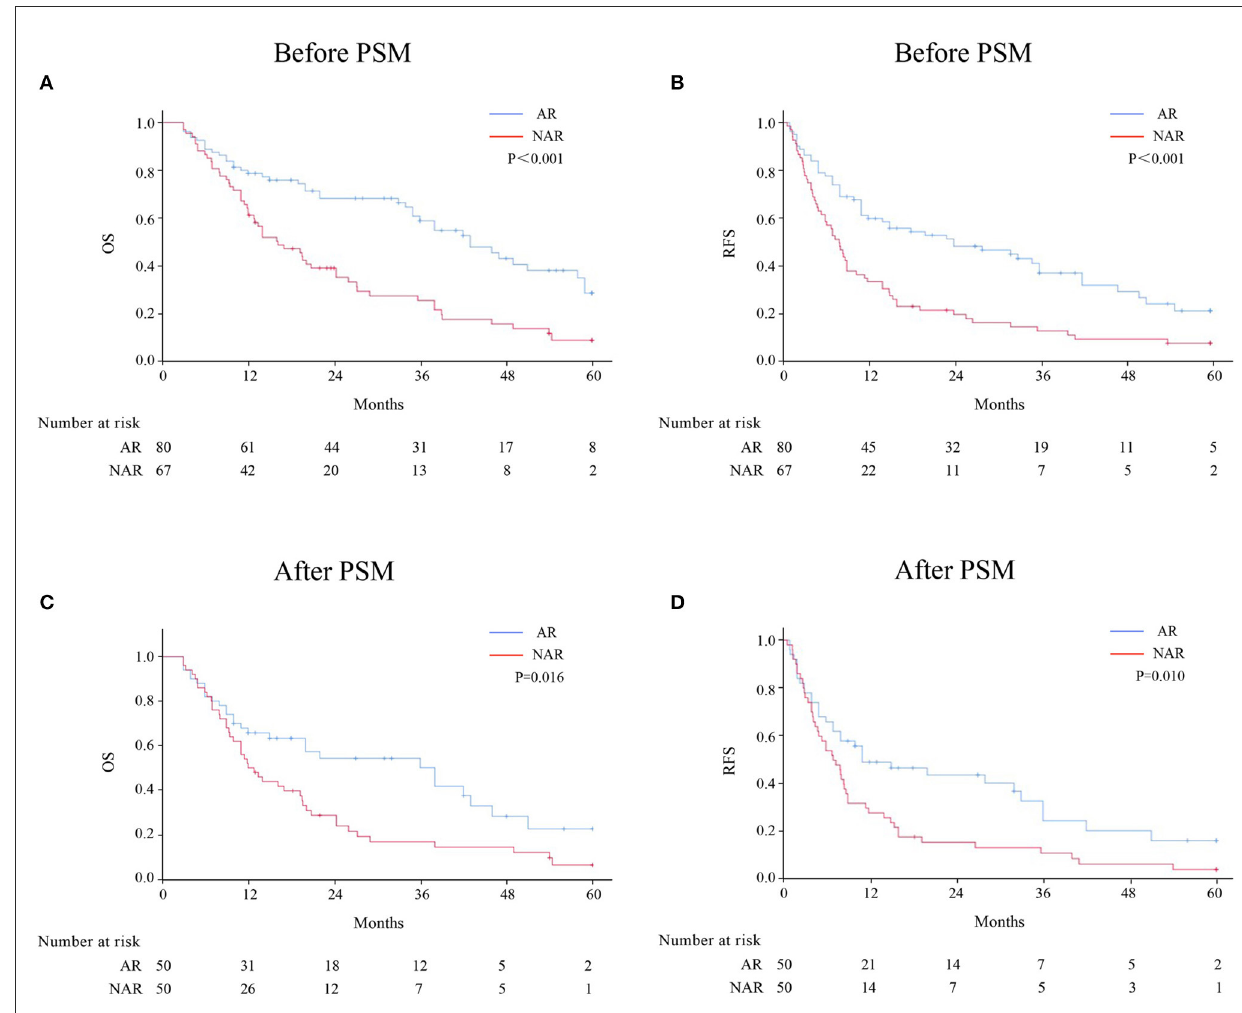
FIGURE1 OS and RFS rates after AR vs. NAR for patients with HICC before (A, B) and after PSM (C, D) .